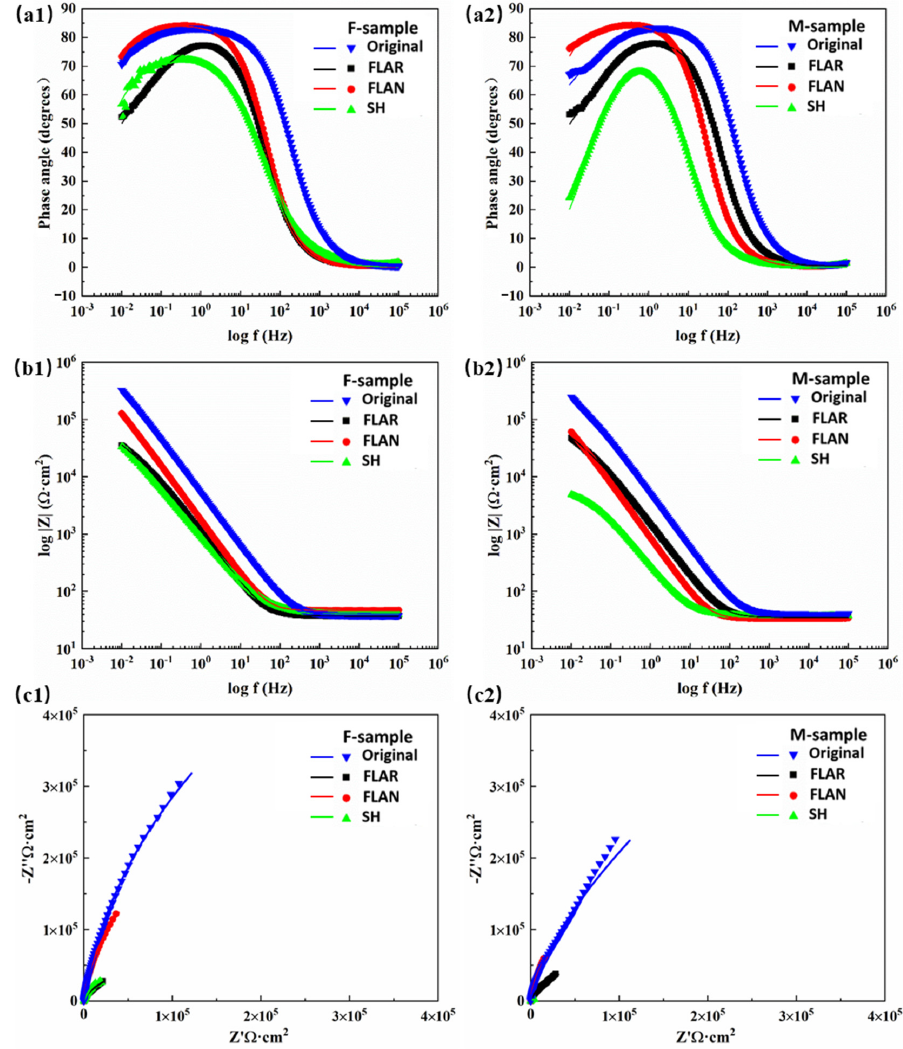
curves and the experiment results fully verifies the circuit’s validity (Figure 6). R f and Q f represent passivation film resistance and capacitance, respectively. R ct and Q dl represent charge transfer resistance and double-layer capacitance. The chi-square values ( χ 2 ) were Figure 6. Measured and simulated ( a ) Bode phase angle, ( b ) Bode impedance, and ( c ) Nyquist curves Figure 6. Measured and simulated ( a ) Bode phase angle, ( b ) Bode impedance, and ( c ) Nyquist curves of SLM-ed samples with different post-treatment processes. results after 72 h are shown in Table 5. of SLM-ed samples with different post-treatment processes.